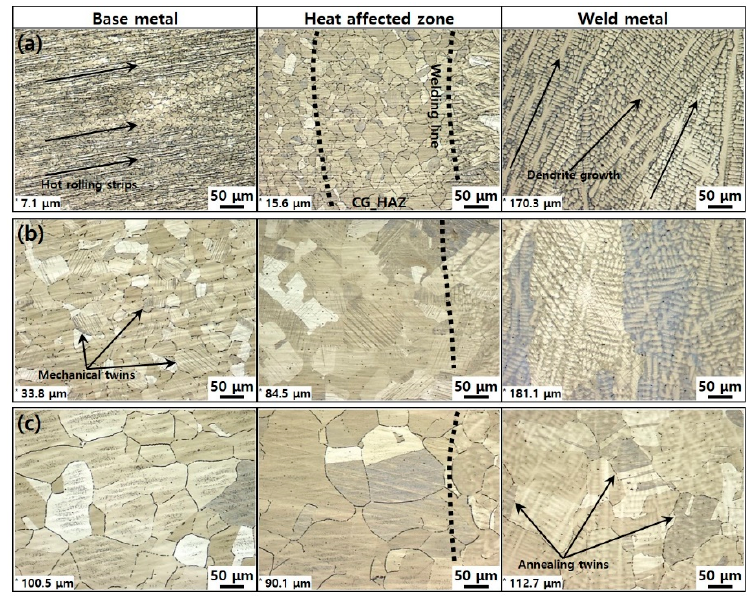
Figure 3. Optical micrographs of high-Mn steel pipes etched by 5% nital for 50 s: ( a ) R, ( b ) 10D, and ( c ) 10DH. (*: Average grain size.)